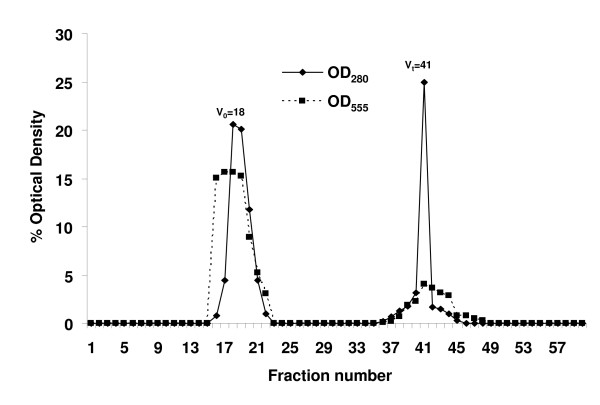
Sepharose CL-4B gel filtration chromatography of hAECS. The percent optical densities at 280 nm (solid line) and 555 nm (dashed line) are indicated on the x-axis while individual column fractions are indicated on the y-axis. The void volume (V0) and total volume (Vt) are indicated.